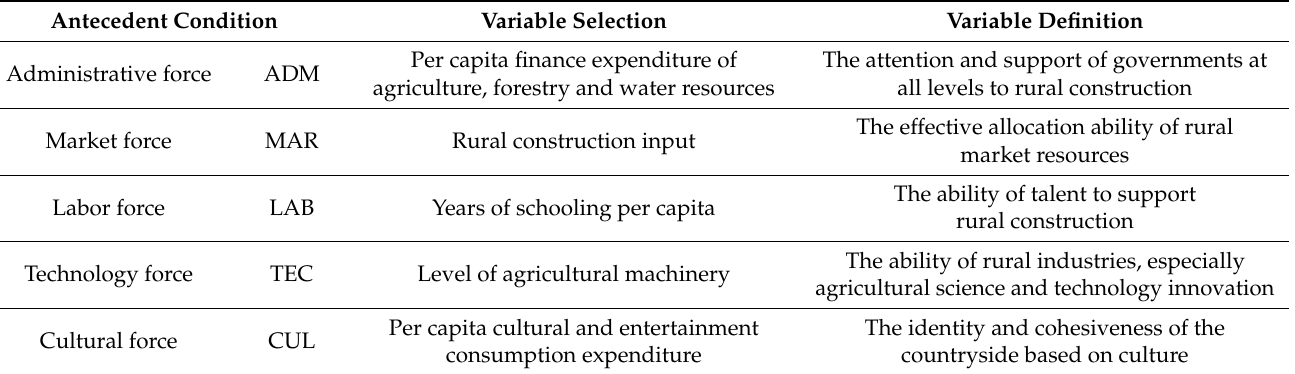
Table 2. Variable selection and